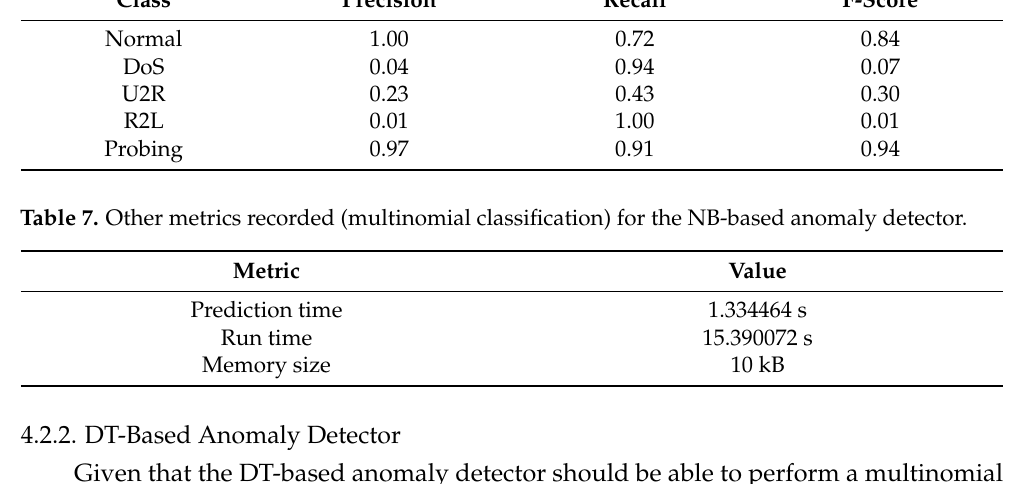
Table 6. NB-basedanomalydetector’straditionalperformancemetricsrecorded(multinomial classification). Class